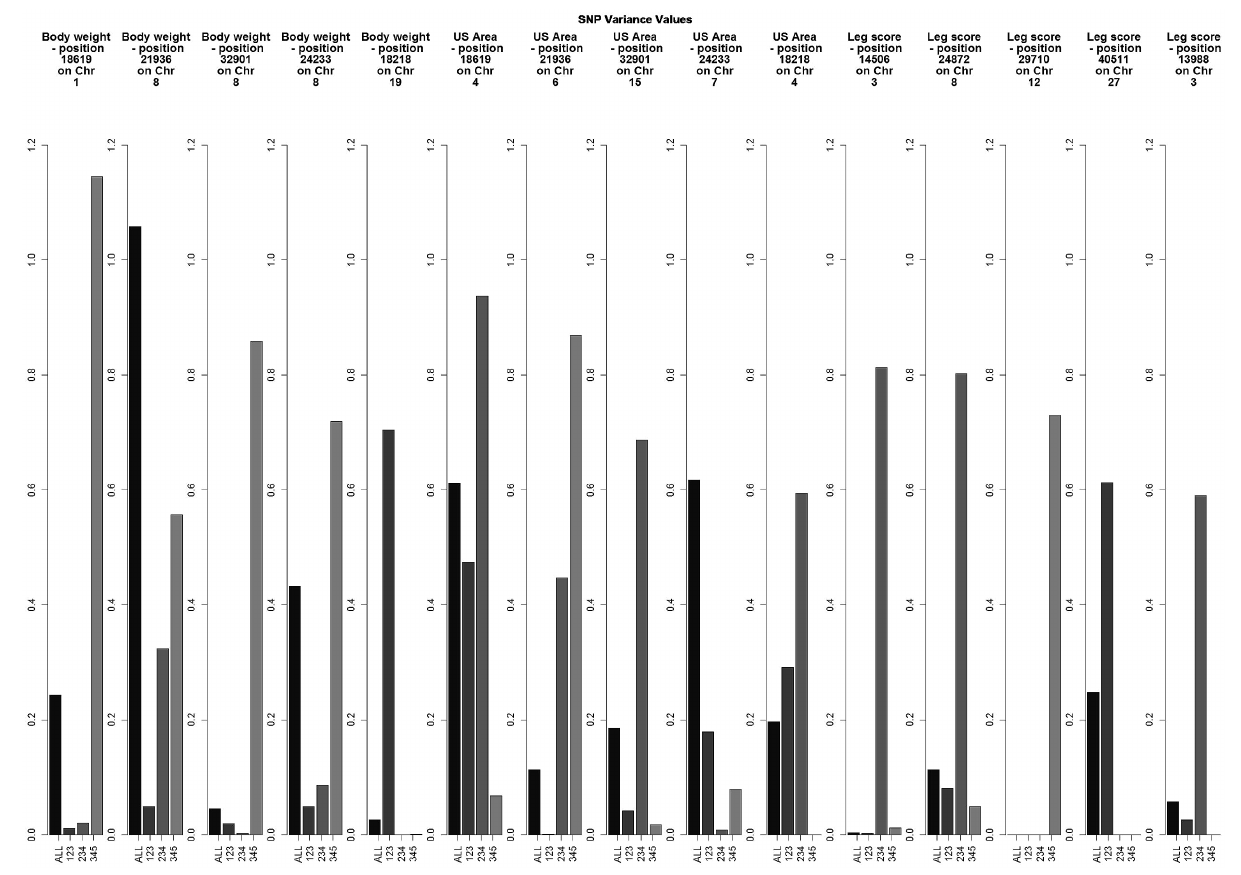
window sizes exhibited large noise with small sizes and absence of peaks with large sizes. Subsequently, windows of 20 SNP were chosen as a reasonable